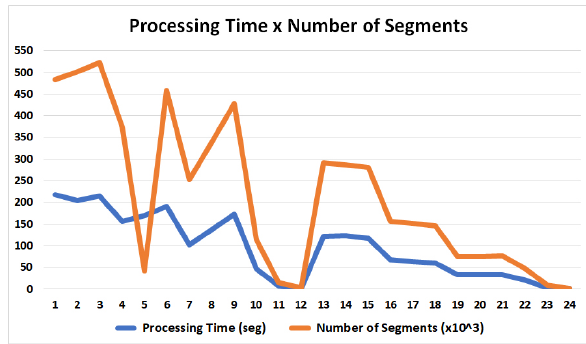
Figure 11. Processing Time Vs Number of Segments